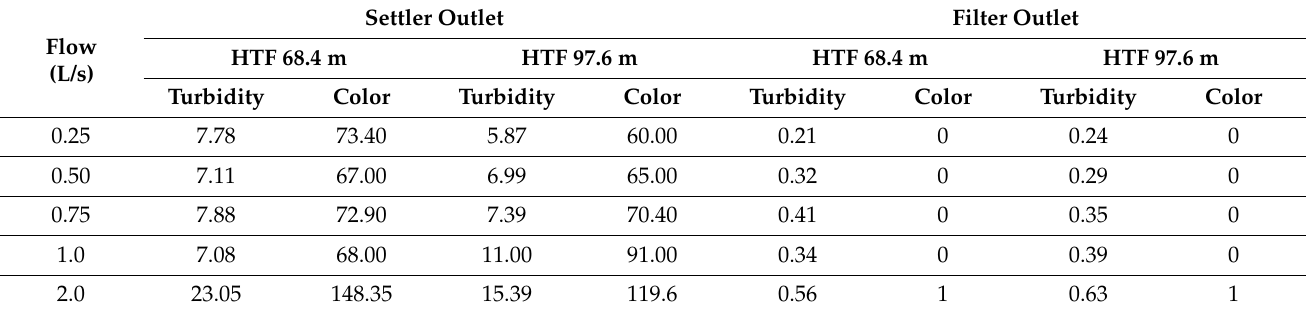
Table 6. Turbidity values in NTU and color in UC Pt-Co obtained at the outlet of the settler and the filter.